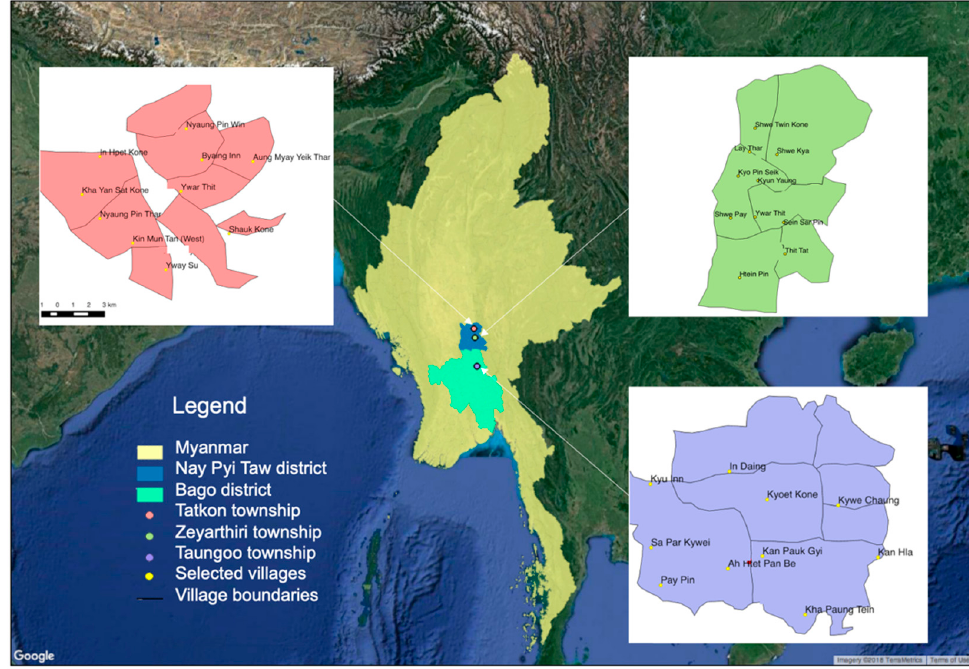
Figure 2. Map of Myanmar showing the study areas.